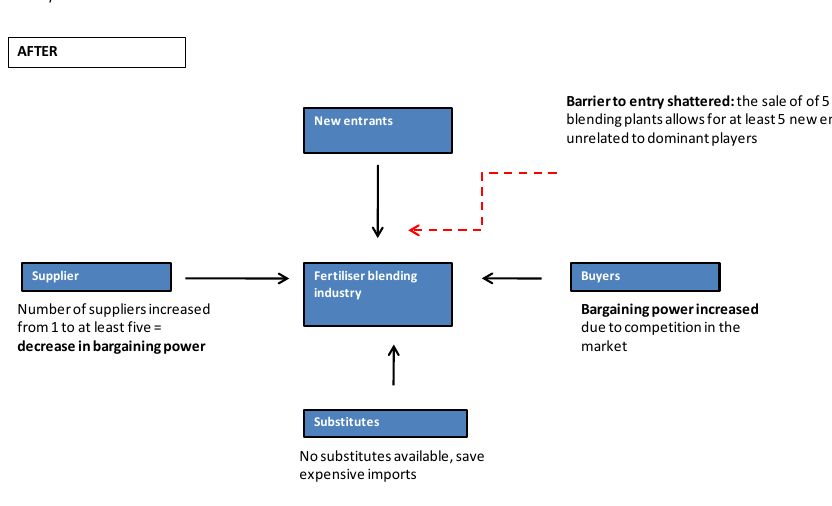
FIGURE 7: Effect of the structural remedy in the Sasol ammonia fertiliser case Source: Compiled by